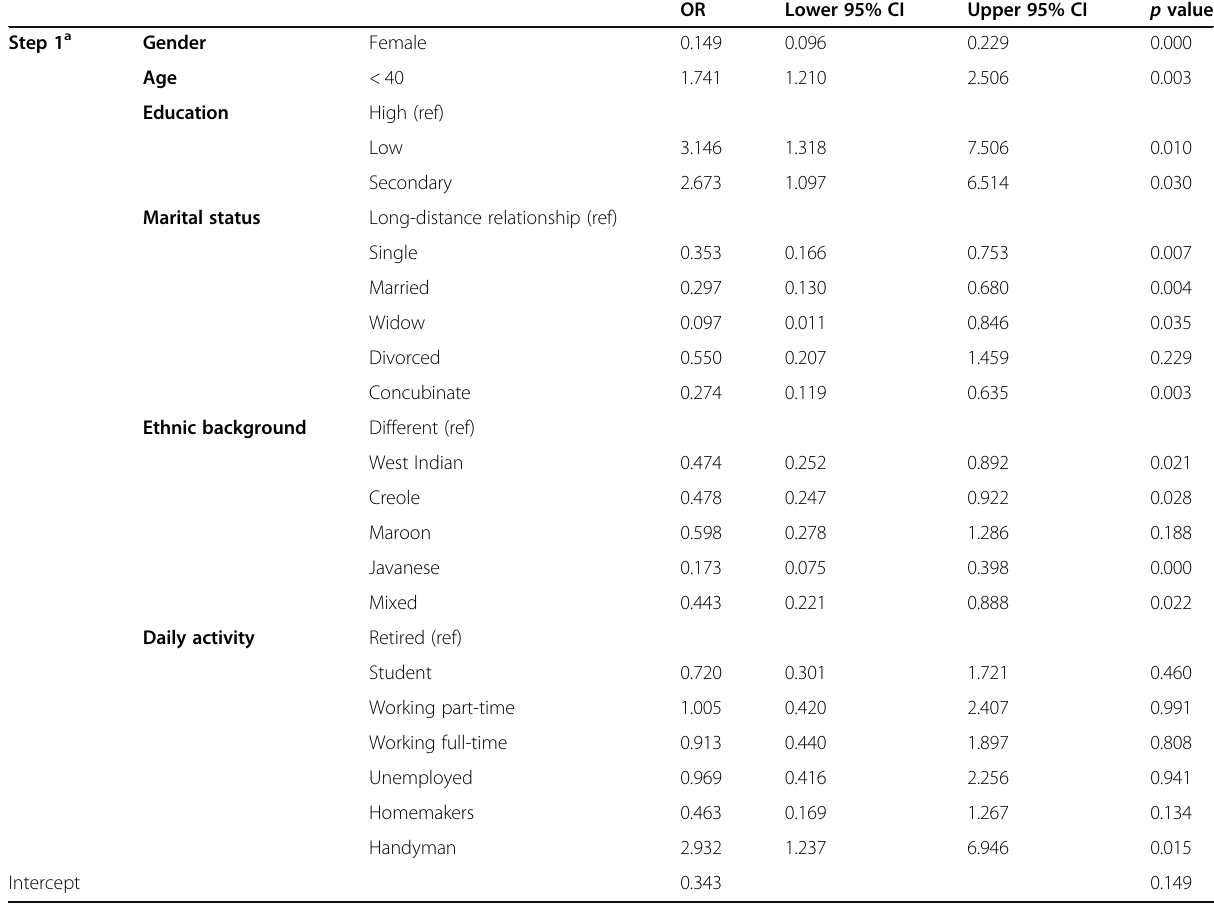
Table 4 Multivariable logistic regression for demographic characteristics associated with alcohol use disorder for both regions